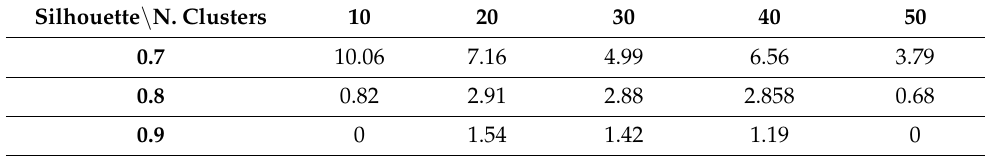
Silhouette \ N. Clusters